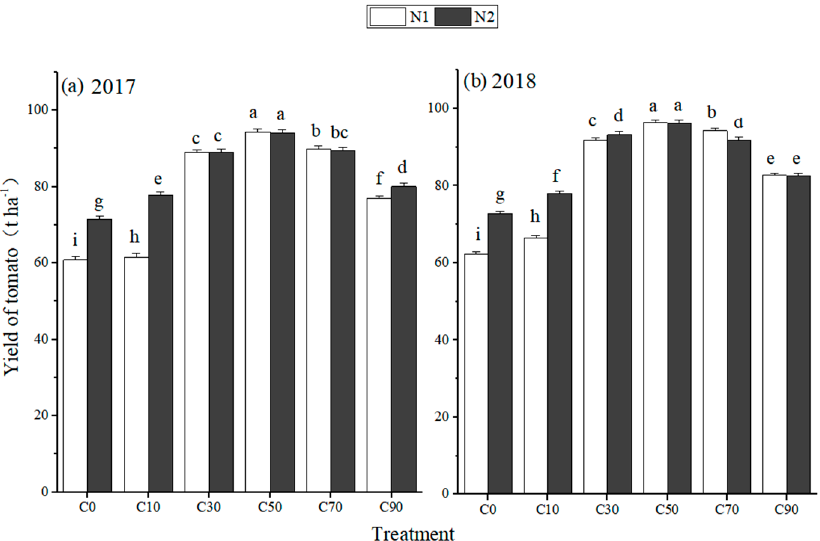
Figure 3. The effect of biochar on tomato yield under low (N1) and normal (N2) nitrogen fertilization in 2017 ( a ) and 2018 ( b ). Different lowercase letters denote significant differences among treatment means at the 0.05 level by the Duncan’s MRT method.